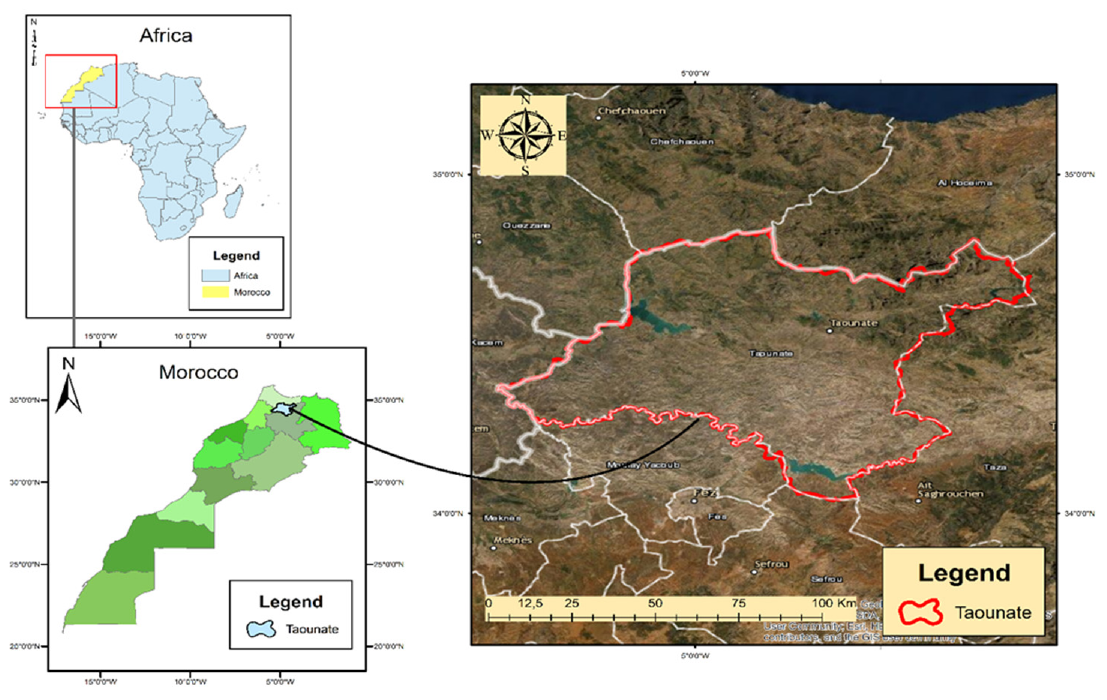
Figure 1. Map showing the sampling area, Taounate province (central northern Morocco).